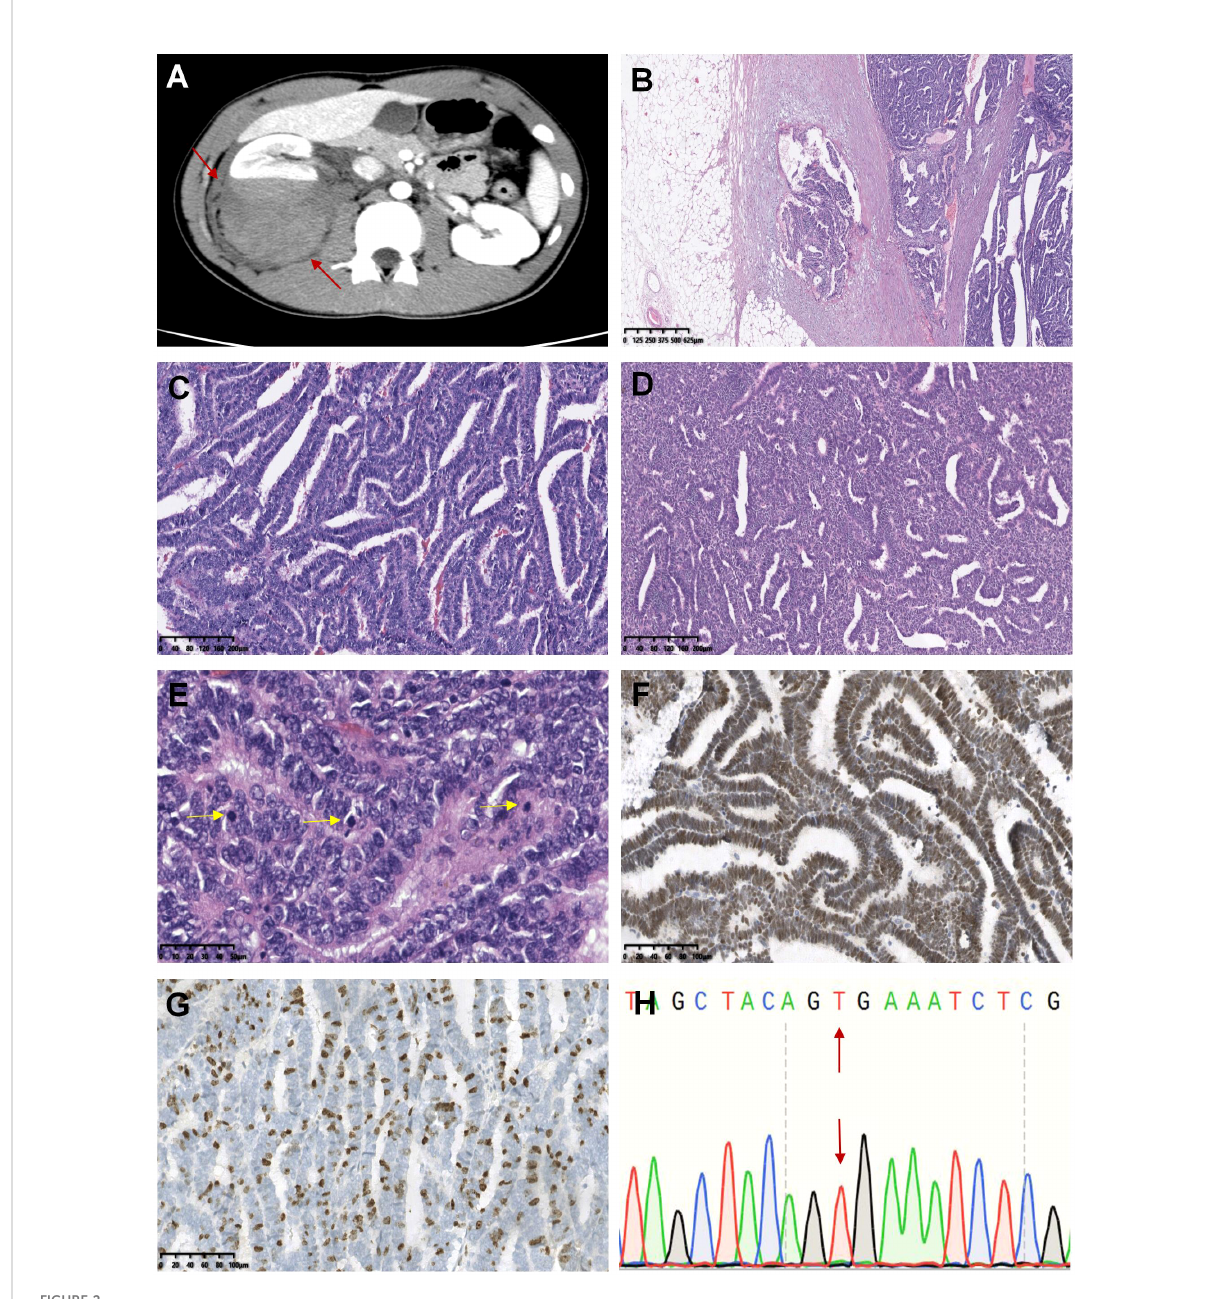
FIGURE 2 Case 21-30 were epithelial-predominant WT. The representative histomorphological images were as follows: In the axial computer tomography scan, the patient ’ s right kidney was characterized by a large swollen mass with uneven density and a clear boundary with the surrounding renal parenchyma, which appeared to invade the perirenal tissue (case 22, A ). Microscopically, the tumor invaded the renal capsule, and carcinoma was observed in the renal fi brous membrane (case 22, B ). Tumor cells were arranged in obvious papillary, acinar or duct structures (case 22 and 23, C, D ). Pathological mitotic fi gures were easily seen and were indicated by the yellow arrows (case 22, E ). WT1 (case 22, F ) and Ki-67 (case 22, G ) were highly expressed in tumors. No BRAF V600E mutation was observed (case 22, H